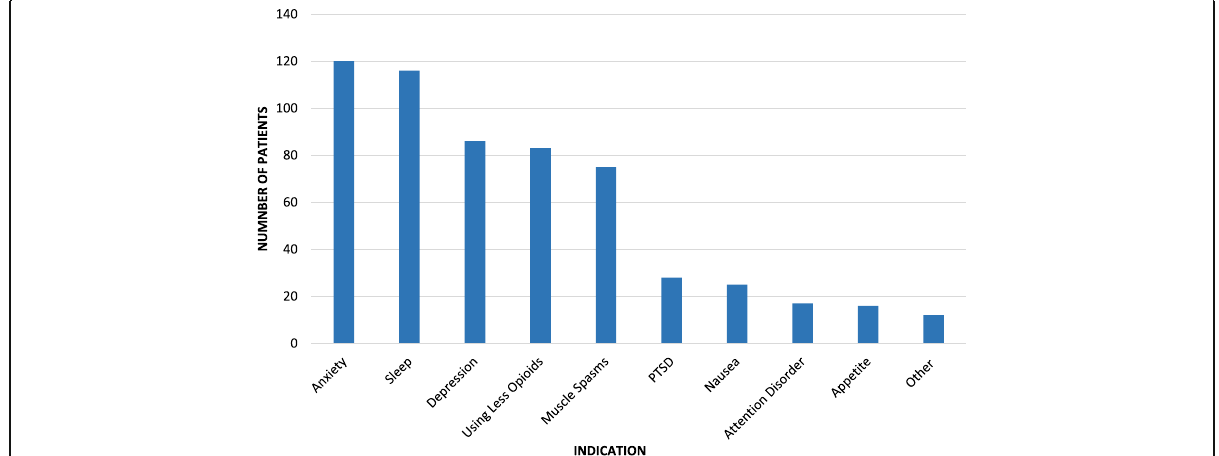
Fig. 2 Responses to question 8: Secondary complaints/indications for medical marijuana among those willing to consider it ( n = 204). Respondents were allowed multiple selections